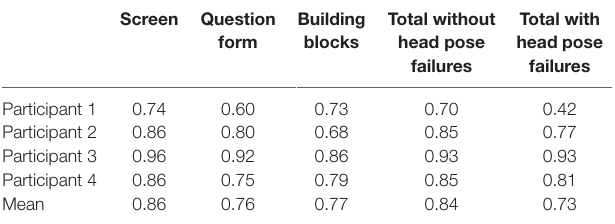
Table 2 | Attention tracking agreement: Cohen’s κ . screen Question